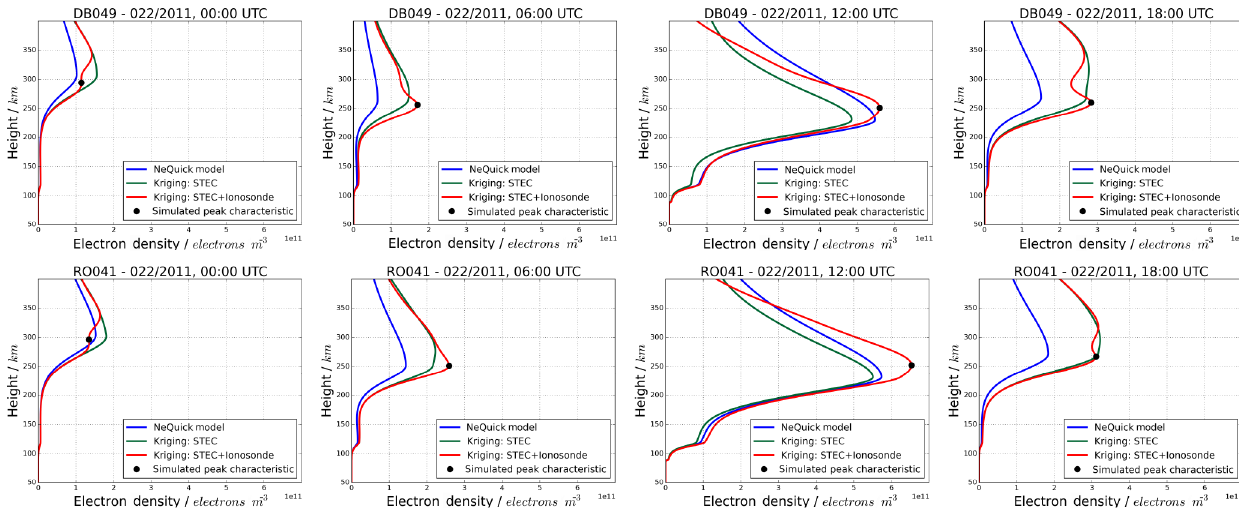
Figure 6. Simulation scenario: comparison of electron density profiles estimated by the NeQuick model (blue), the kriging with spatial covariance MI (green) and the GEK with spatial covariance MIII (red). The peak characteristics (black) at the ionosonde station locations of DB049 (top row) and RO041 (bottom row) on DOY 022/2011 are simulated by the models NPHM and NPDM. The assimilated STEC is simulated by NTCM.